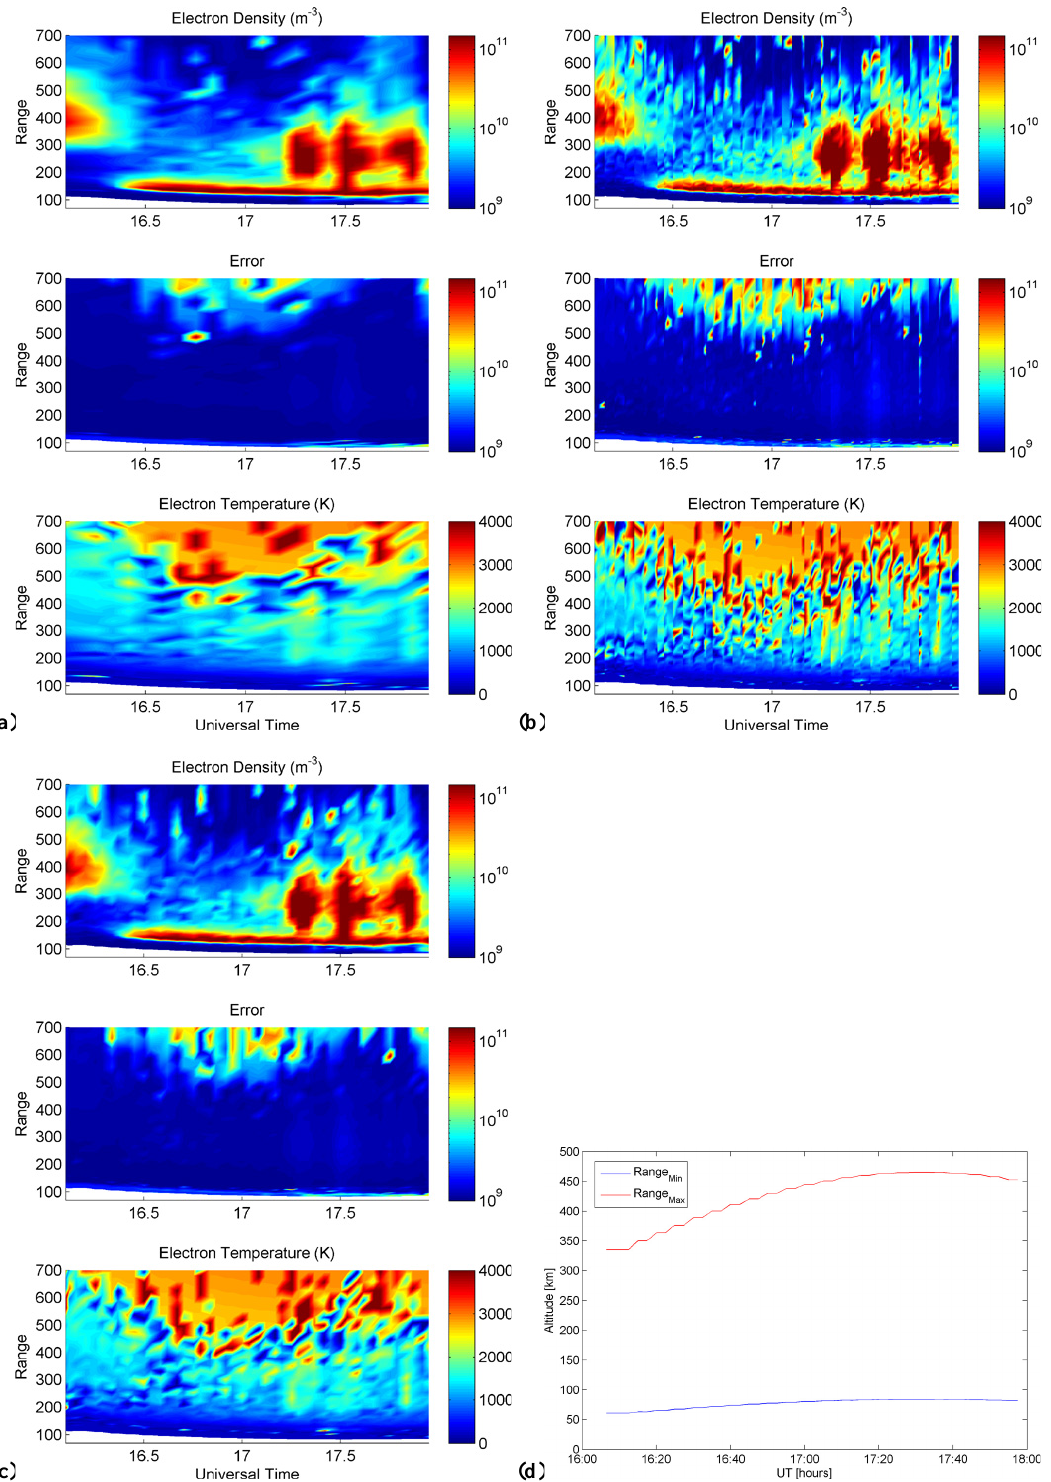
Fig. 2. Different integration times, evaluation of errors and integration ranges: (a) 5min; (b) 60s; (c) 150s; (d) vertical altitudes correspond- ing to EISCAT ranges in the case of 12 December